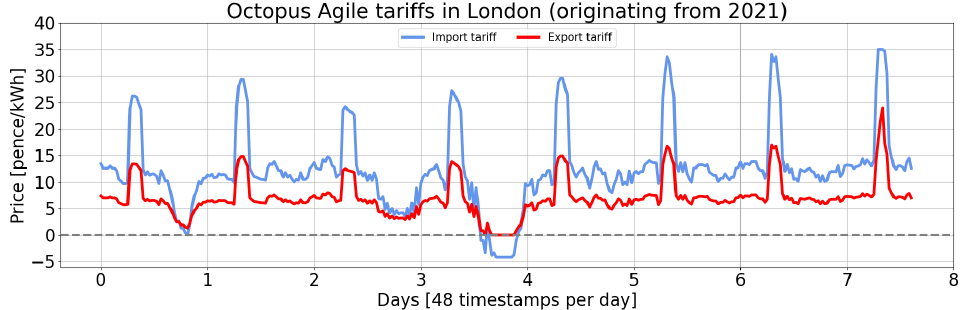
Figure 7. Indication of the shape of Octopus Agile import and export tariffs used during